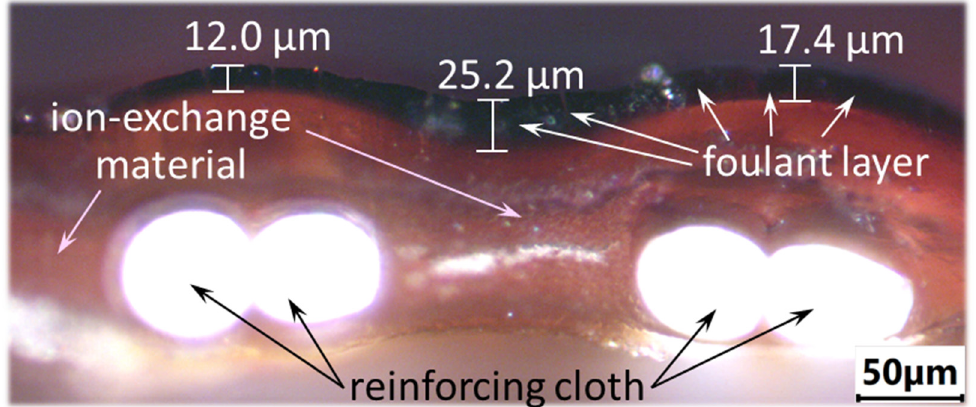
Figure 8. Surface photos and optical images of CJMA-6 membrane cross-sections before ( a ) and after ED processing of model solutions 3 ( b ) and 4 ( c ).